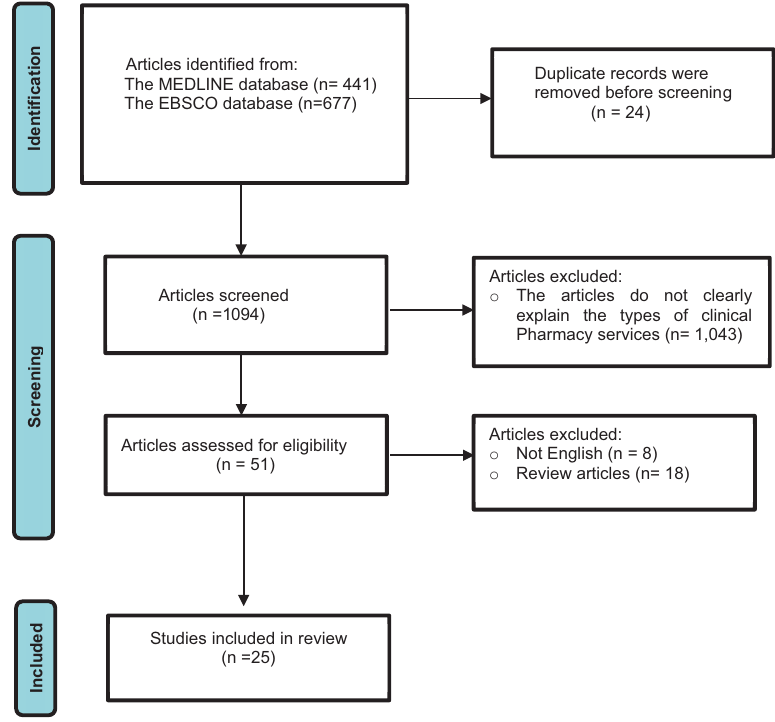
Figure 1. PRISMA flow diagram of the literature